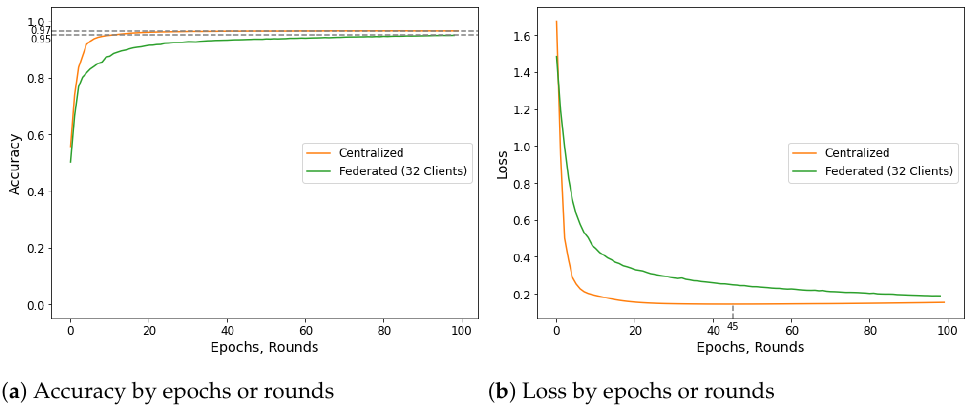
Figure 7. Comparison between centralized learning and federated learning for Internet traffic application classification (32 clients and 100 rounds for